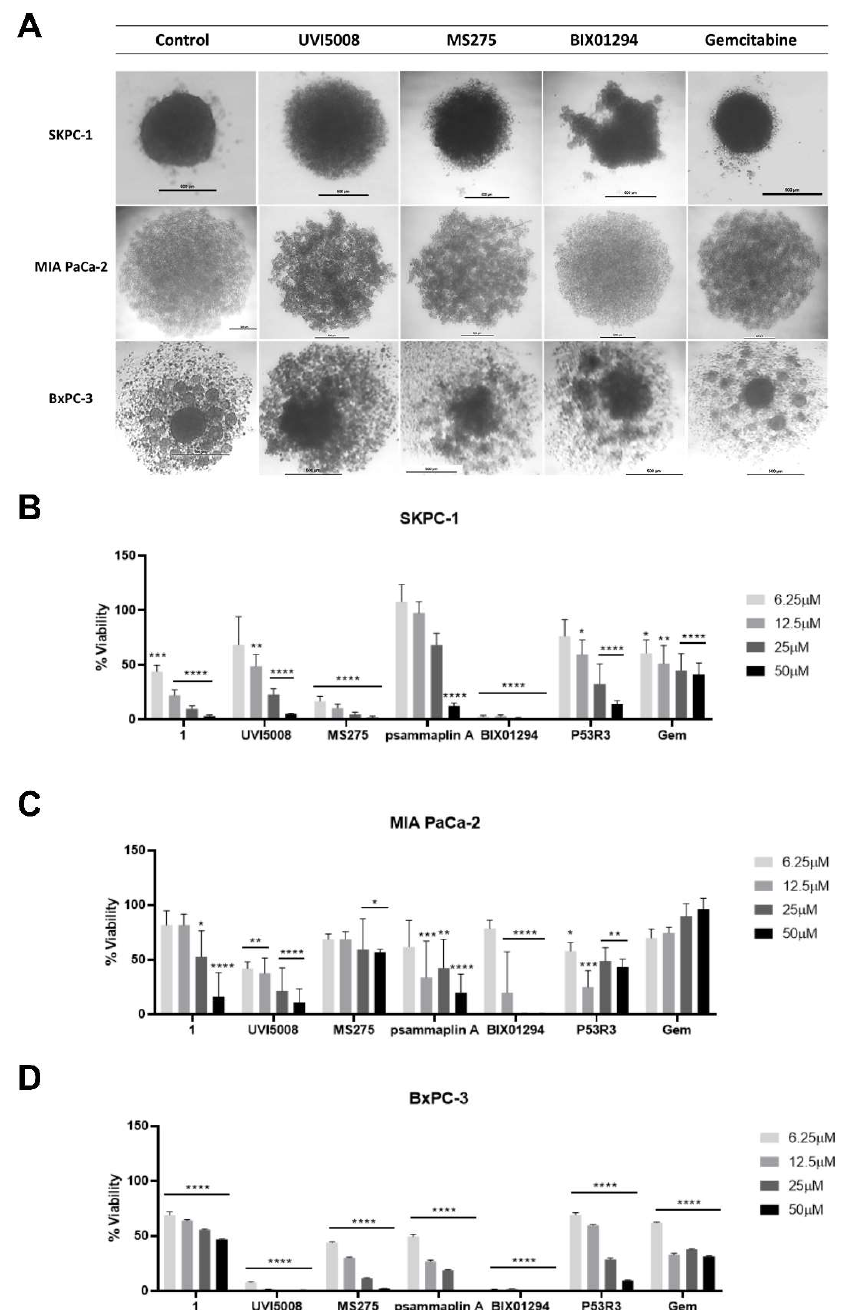
Figure 3. Antitumoral effect induced by the epigenetic inhibitors 1 (MS275 analogue), 2 (UVI5008), 3 (MS275), 4 (psammaplin A), 5 (BIX01294), and 6 (P53R3) and gemcitabine (Gem) in SKPC-1, MIA PaCa-2, and BxPC-3 spheroids. ( A ) Optical microscope images of the spheroids: untreated (control), and treated with UVI5008, MS275, and BIX01294 at the highest concentration tested (50 µM). Scale: 500 µm. Percentage of cell viability on the SKPC-1 ( B ), MIA PaCa-2 ( C ), and BxPC-3 ( D ) spheroids treated with the anti-tumoral drugs at four different concentrations. Statistically significant differences compared to untreated cells were represented as: * p ≤ 0.05, ** p ≤ 0.01, *** p ≤ 0.001, **** p ≤ 0.0001.